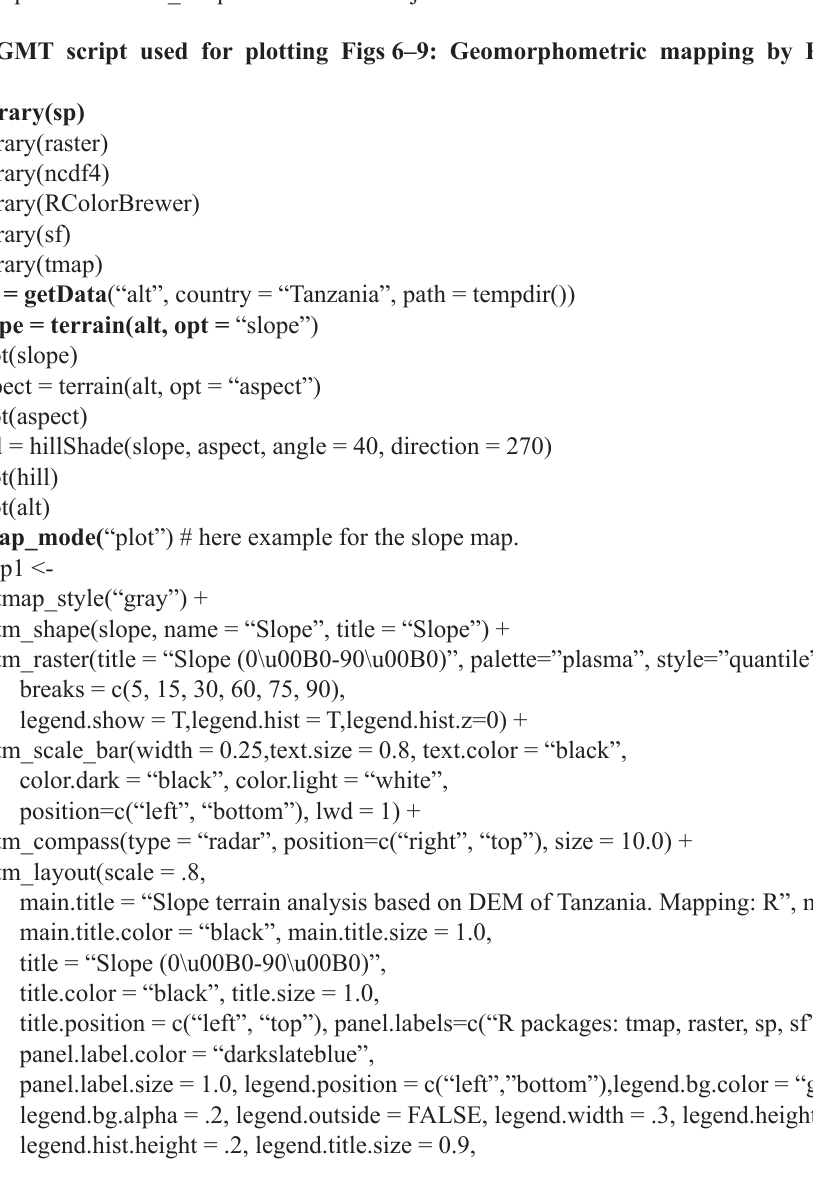
main.title = “Slope terrain analysis based on DEM of Tanzania. Mapping: R”, main.title.position = “center”, main.title.color = “black”, main.title.size = 1.0, title = “Slope (0\u00B0-90\u00B0)”, title.color = “black”, title.size = 1.0, title.position = c(“left”, “top”), panel.labels=c(“R packages: tmap, raster, sp, sf”), panel.label.color = “darkslateblue”, panel.label.size = 1.0, legend.position = c(“left”,”bottom”),legend.bg.color = “grey90”, legend.bg.alpha = .2, legend.outside = FALSE, legend.width = .3, legend.height = .5, legend.hist.height = .2, legend.title.size =